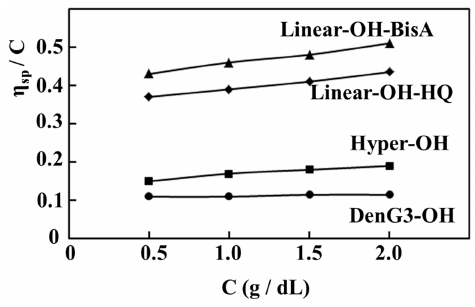
Figure 4. Reduced viscosities of DenG3-OH , Hyper-OH , Linear-OH-BisA and Linear-OH-HQ .